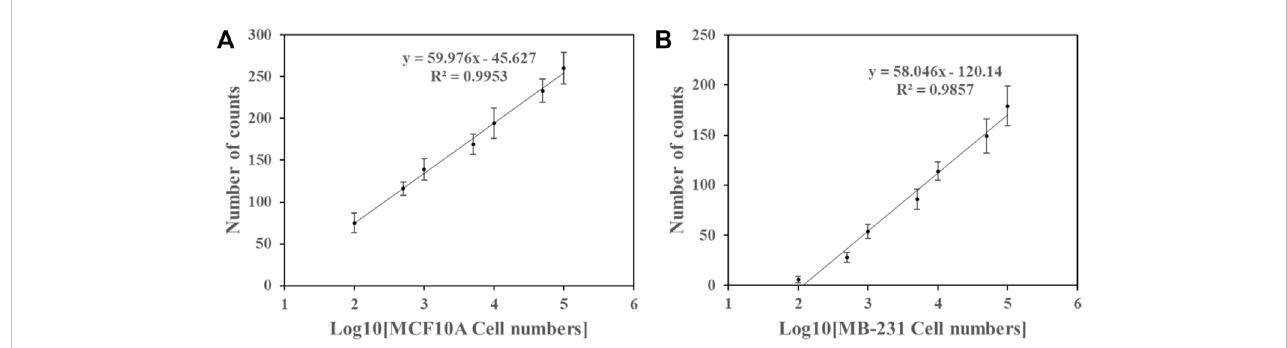
FIGURE 4 ThenumberofCy5spotcountsandthelogarithmofthecellnumbercountsexhibitedalinearrelationinthesamplesof (A) MCF10Acellsand (B) MB-231 cells. Error bars represent the standard deviation of three